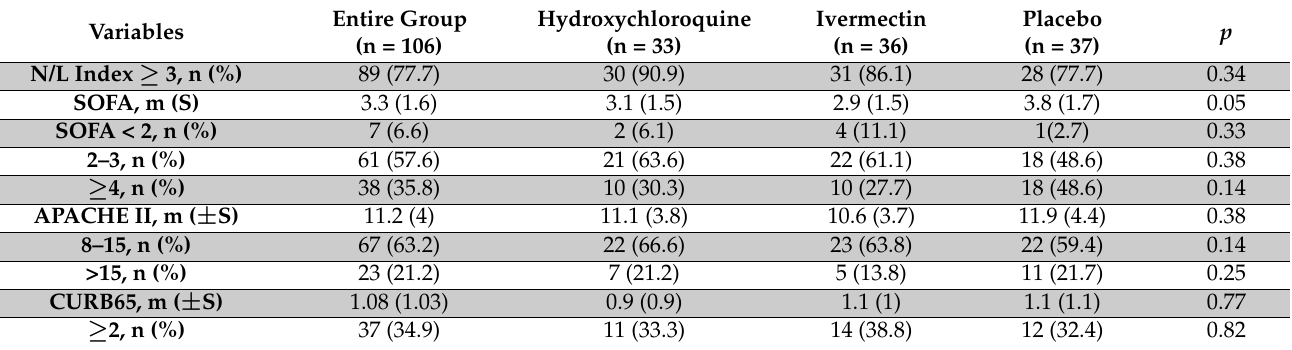
Table 4. Markers and prognostic score systems.